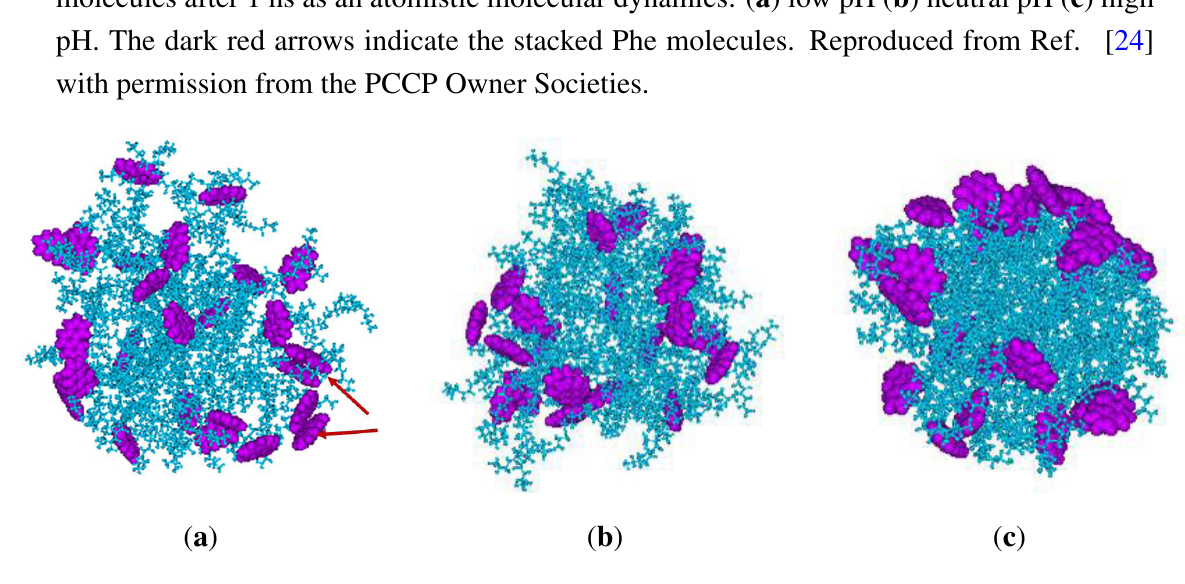
Figure 3. Interaction of PAMAM dendrimers with fullerenols at neutral pH: ( a ) Two fullerenols in proximity to one G1 dendrimer within 1.5 nm of the center of mass of the dendrimer ( b ) 21 fullerenols in proximity to one G4 PAMAM dendrimer within 3.5 nm of the center of mass of the